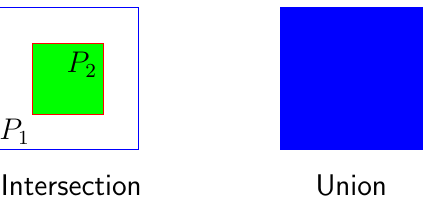
Figure 8. Intersection over the union when a small bounding box ( P 2 ) is totally included within a large one ( P 1 ). The area of the intersection corresponds to the area of P